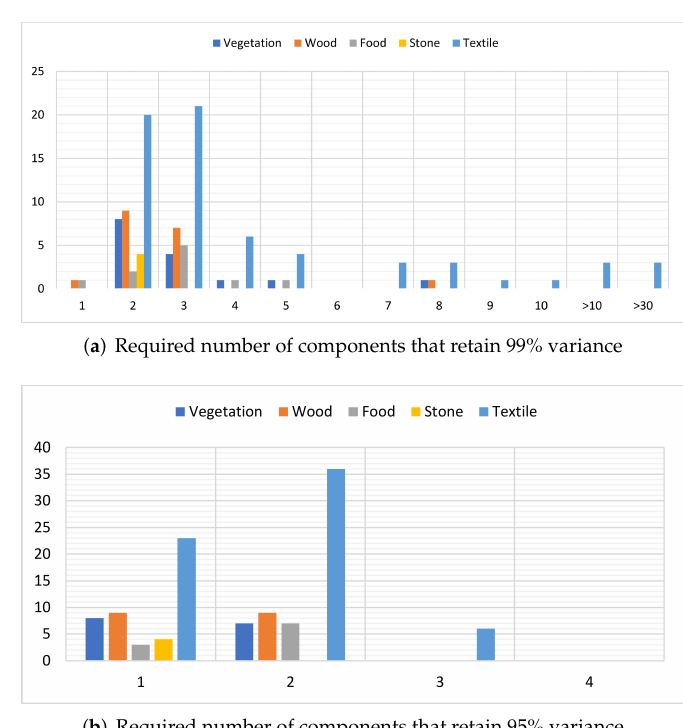
Figure 11. Results of the principle component analysis (PCA) on each image from the five categories of the hyperspectral dataset. The x -axis represents the effective dimension, while the y -axis shows the number of images with that effective dimension. Most of the spectral data in our dataset can be represented by 1, 2 or 3 dimensions while retaining 95% of the